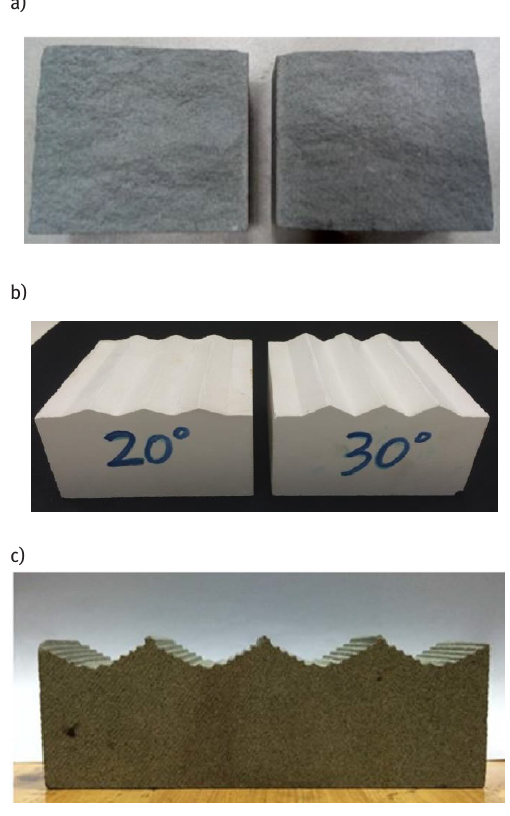
Figure 2: Types of rock joints: a) natural joint, [15] b,c) artificial rock interfaces [13,16]